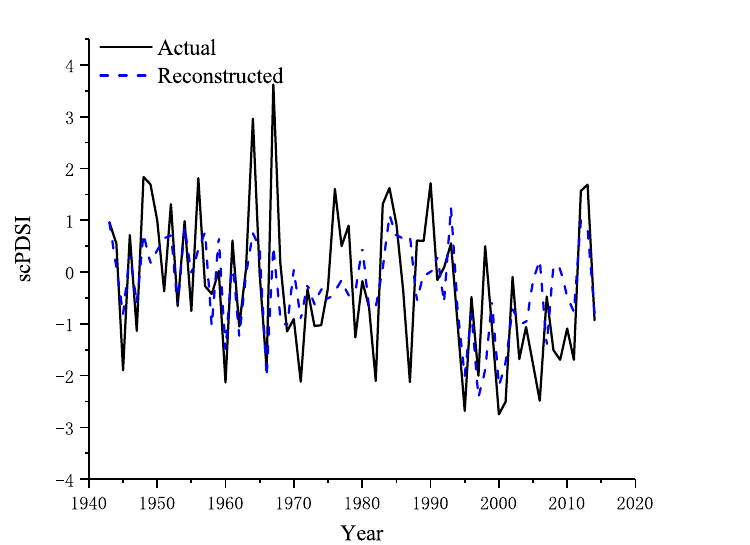
Figure 3. Comparison of reconstructed scPDSI with actual scPDSI for